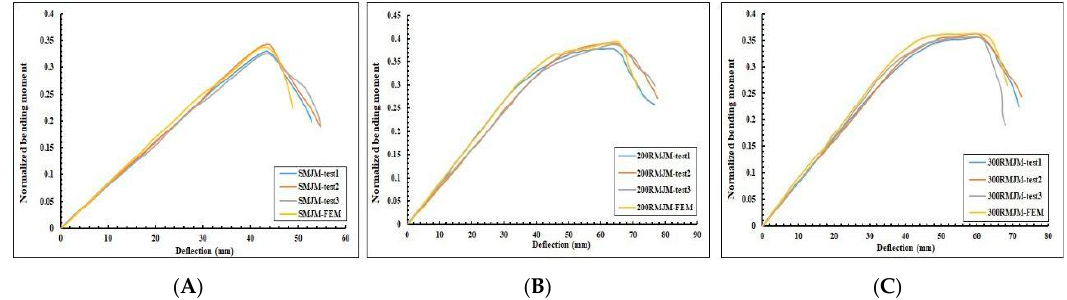
Figure 28. Finite element model and experimental curves for major axis test set-up: ( A ) non-reinforced frame types; ( B ) 200 mm reinforced frame types; ( C ) 300 mm reinforced frame types.